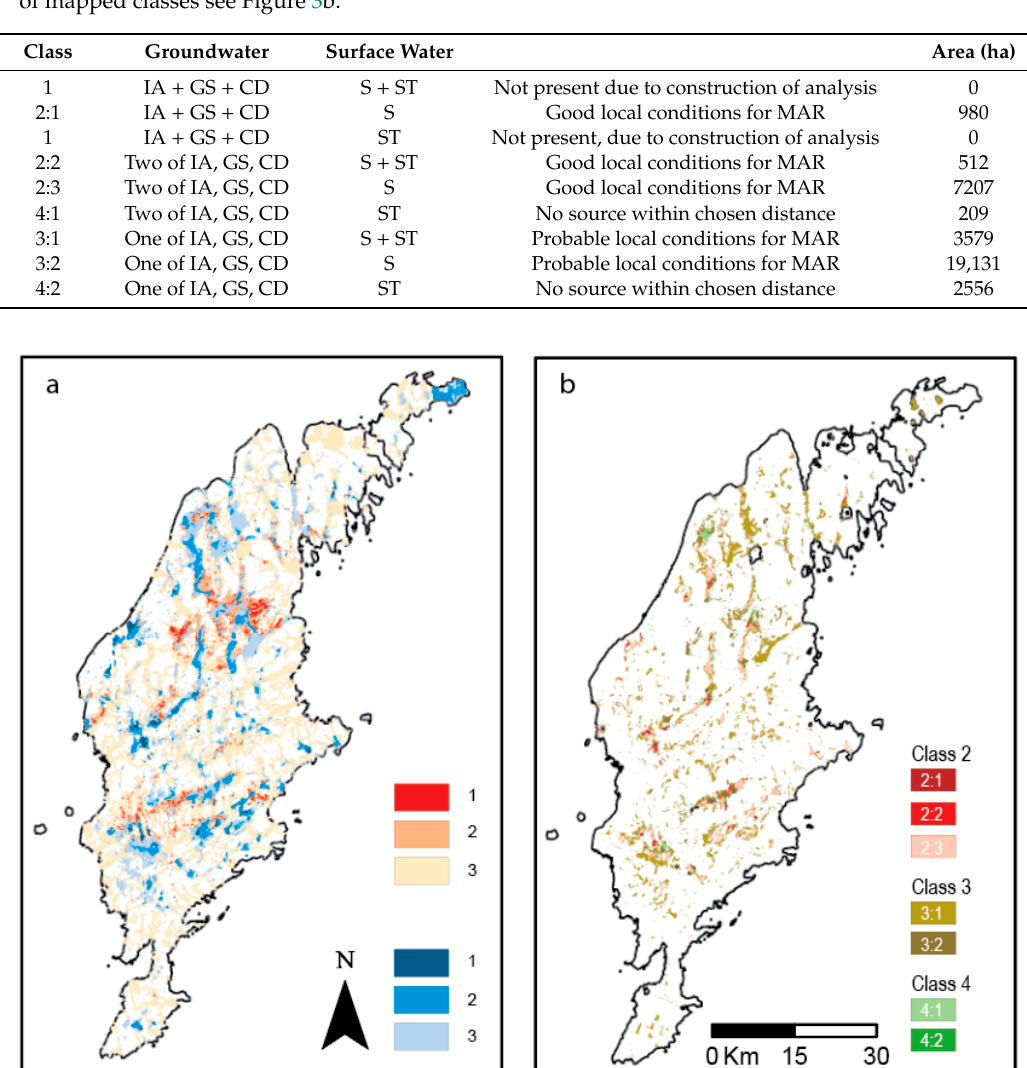
Figure 3. Maps from combined GIS analysis. ( a ) Combination of overlapping datasets from Figure 2a,b. Please note that since the raster set with surface water source/storage is made with a buffer there will be areas with overlapping datasets. ( b ) Map with the best areas for infiltration/groundwater storage and source/surface water storage. Classes are defined in the text and summarized in Table 1. Table 1. Synthesis from final step in GIS analyses. GS = Ratio >1.0 groundwater recharge/storage capacity; CD = Closed depression; IA = sand/gravel >4m; S = Raw water Source; ST = Storage. Location of mapped classes see Figure 3b.